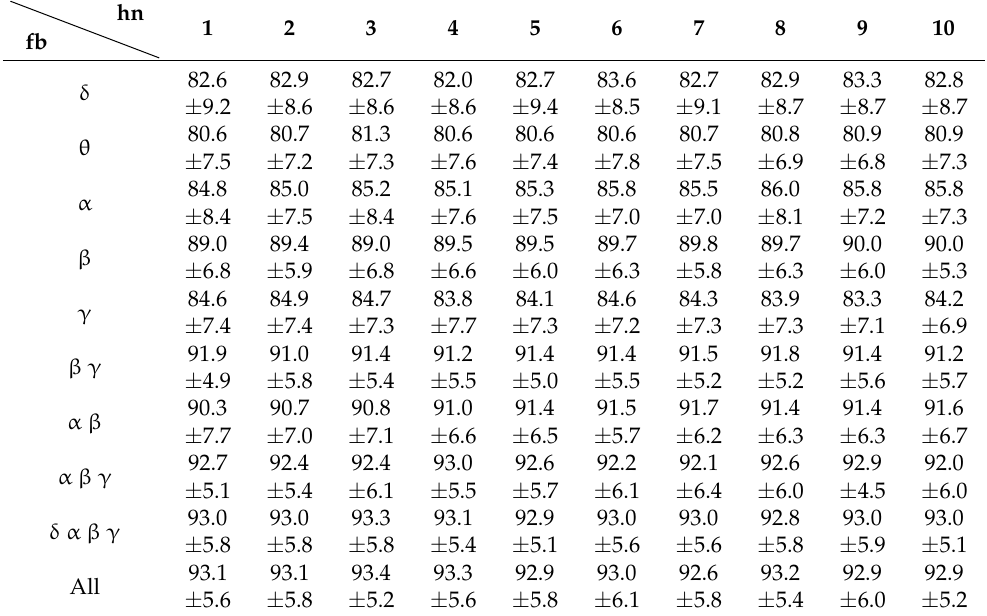
Table 2. Mean and standard deviation of accuracy for selected EEG frequency bands (fb) and a different number of hidden neurons (hn). Results for the second scenario in which feature set vectors for the training and testing datasets were derived from separate recording